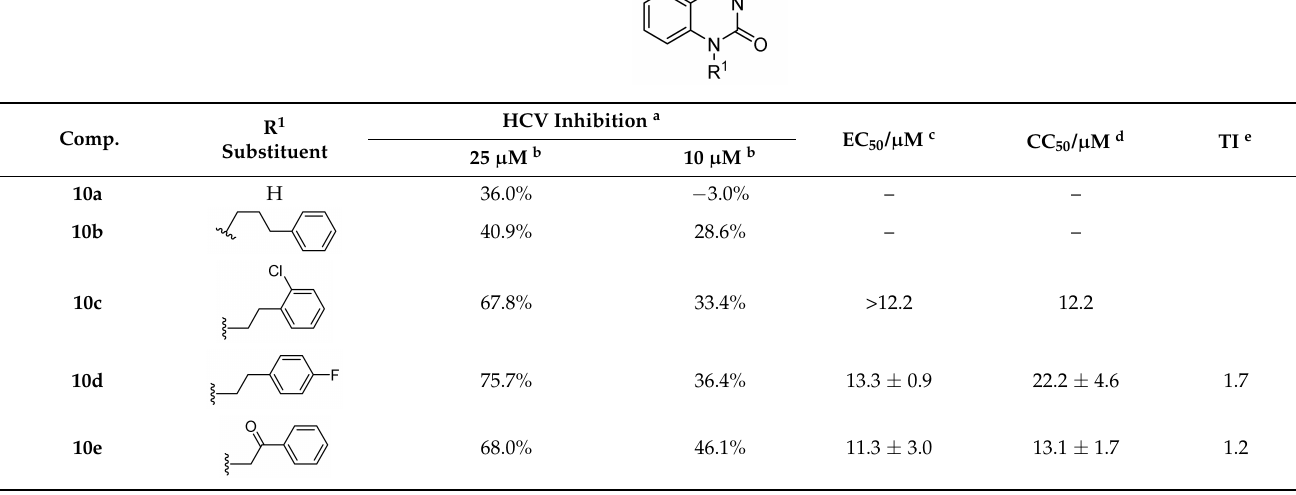
Table 1. Anti-HCV assay of N-1 substituted 3-hydroxy-quinazoline-2,4(1 H ,3 H